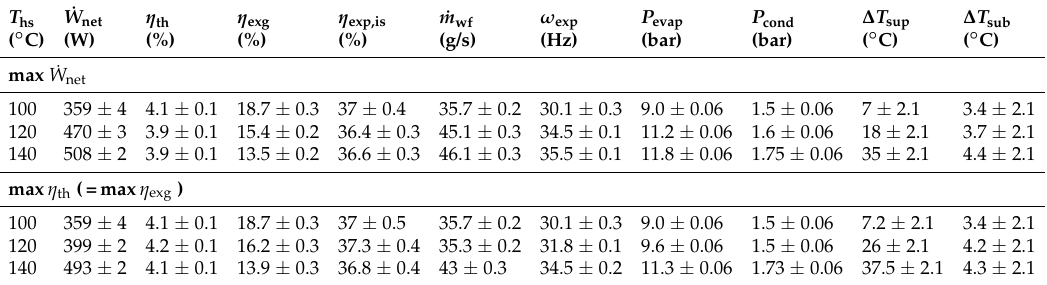
Table 2. Optimum operating conditions for various heat-source temperatures, which maximise either the net power output or thermal (and exergy) efficiency. The points described in this table are highlighted in red in Figure